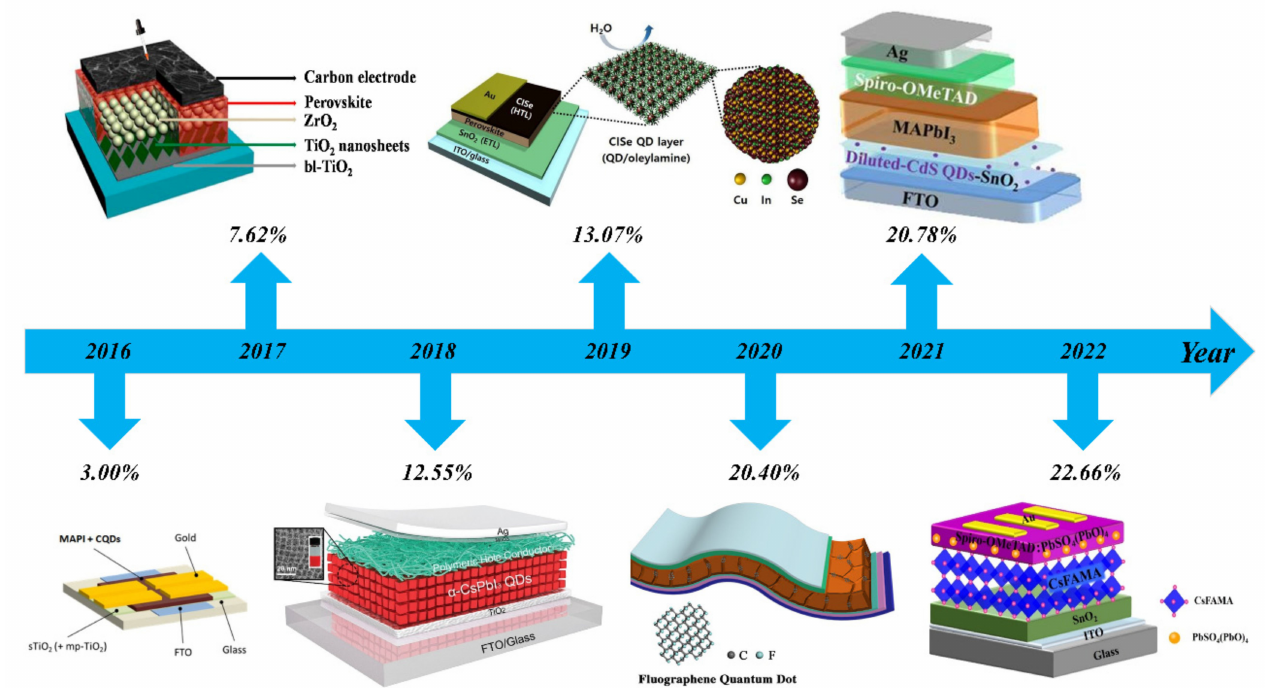
Figure 1. Annual progress of PSCs from 2016 to 2022. Power conversion efficiency, device structure, and major breakthroughs of different types of device are illustrated [39–45]. Reproduced from [39–42], with permission from Elsevier, 2016, 2017, 2018, 2019. Reproduced from [43–45], with permission from American Chemical Society 2020, 2021,